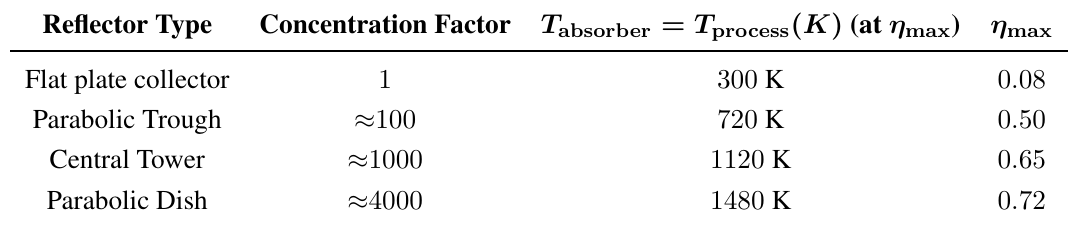
Indicative values of concentration factor, receiver temperature at maximum efficiency for different concentrator types (as observed from adapting Figure 1